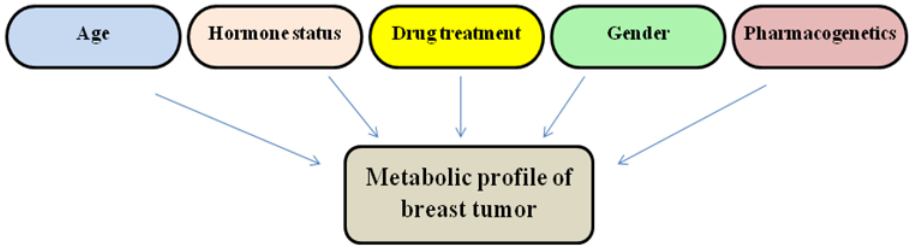
Figure 1. Metabolomics analysis of tumors depends on multiple factors associated with an individual